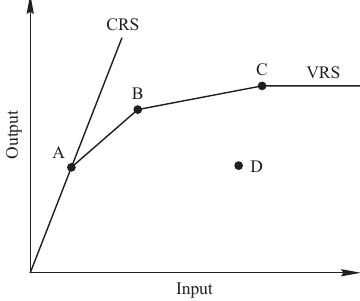
Fig. 1. CRS vs. VRS